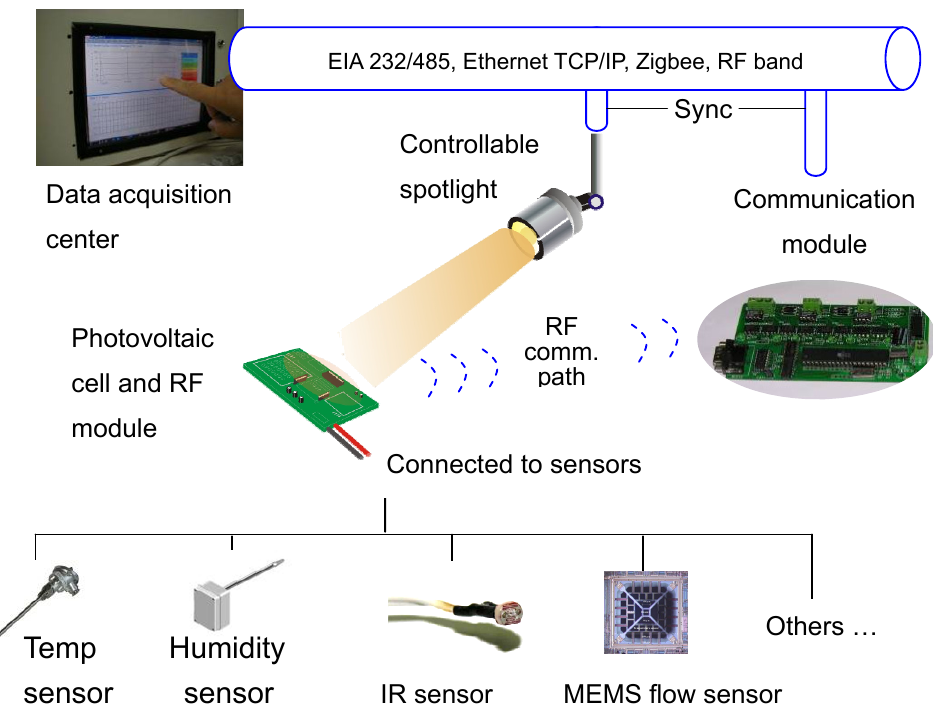
Figure 1. A schematic view of the light powered sensor